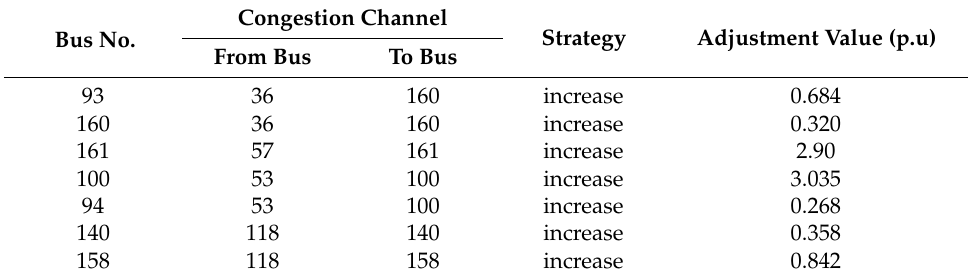
Table 3. Reactive power adjustment results.